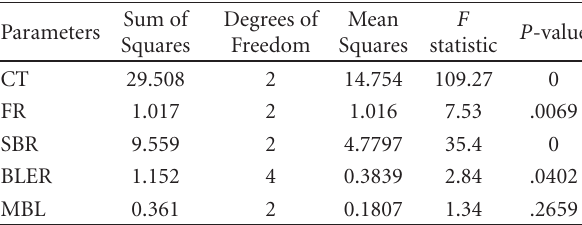
Table 4: Five-way ANOVA on